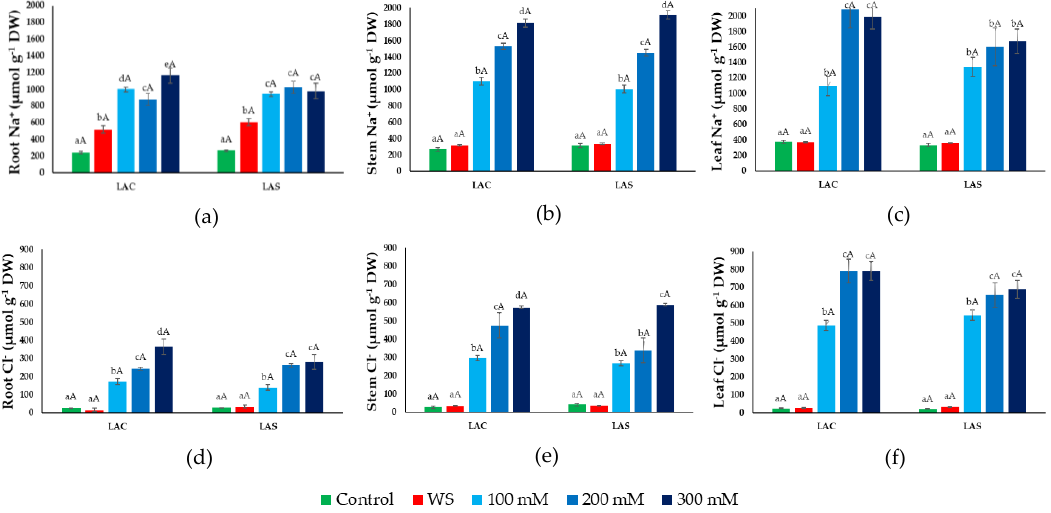
Figure 5. Ion contents under water deficit and salt stress conditions. Sodium (Na + ) ( a , b , c ) and chloride (Cl − ) ( d , e , f ) concentrations in roots ( a , d ), stems ( b , e ), and leaves ( c , f ) of L. angustifolia var. ‘Codreanca’ (LAC) and var. ‘Sevtopolis’ (LAC) plants after 30 days of growth under control conditions, in the presence of the indicated NaCl concentrations or subjected to water stress (WS) (completely withholding irrigation). DW, dry weight. Bars represent means ± SE (n = 5). Different lowercase letters above the bars indicate significant differences between treatments for each variety, and different uppercase letters indicate significant differences between the two varieties for plants undergoing the same treatment, according to the Tukey test (α = 0.05).